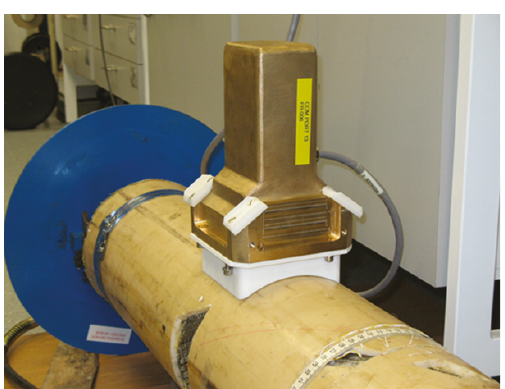
Figure 4: MAPS-FR